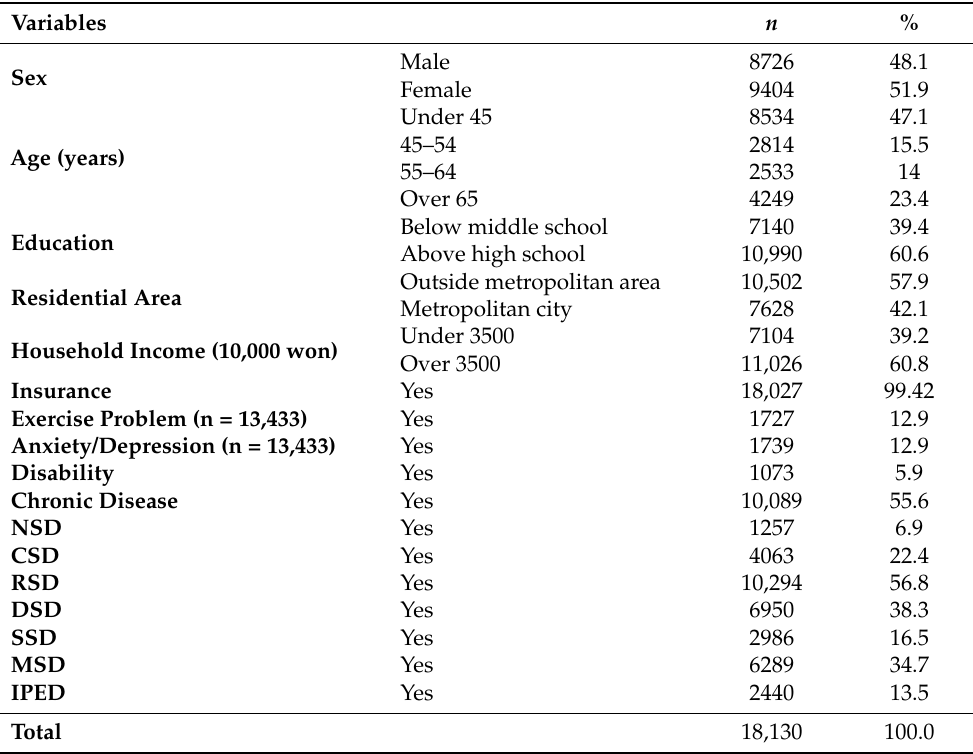
Table 2. General Characteristic of Respondents (N = 18,130, All